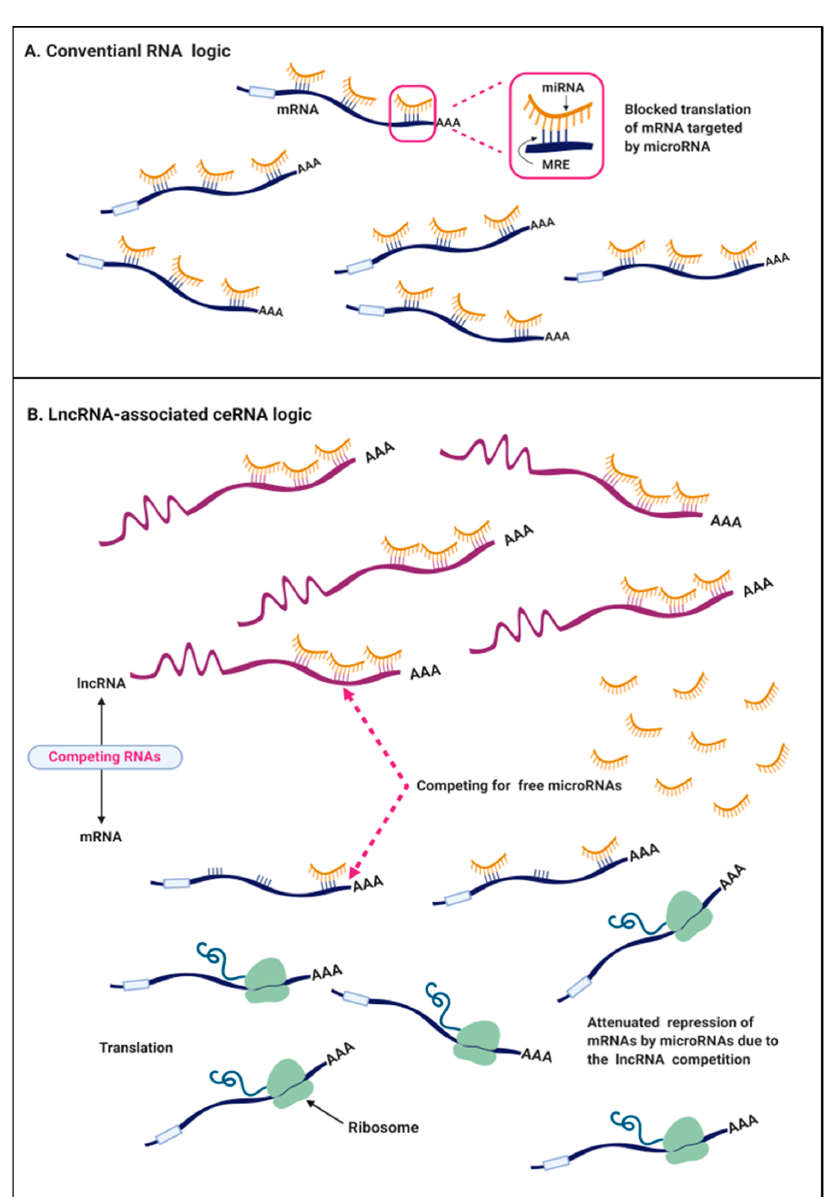
Figure 2. The competitive endogenous RNA (ceRNA) mechanism. ( A ) In the conventional crosstalk of RNA transcripts, in the cytoplasm, miRNAs exert the suppressive function on protein-coding mRNAs by base pairing with partial complementarity via the miRNA recognition element (MREs) mapped to the 3 ′ UTR of mRNAs. ( B ) Under the ceRNA mechanism in cancer cells, aberrantly expressed long noncoding RNAs (lncRNAs) with MREs competitively sequestrate miRNAs and reduce the interaction between miRNA and mRNA, and thus attenuate the repression on the downstream mRNAs.